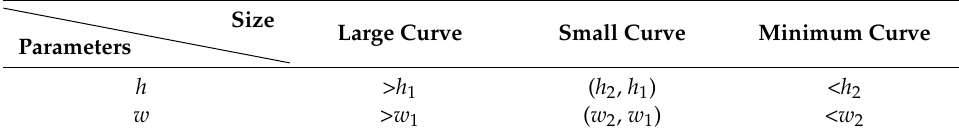
Table 1. Criteria values of [ h 1 , h 2 , w 1 , w 2 ] to determine the sizes of curves.